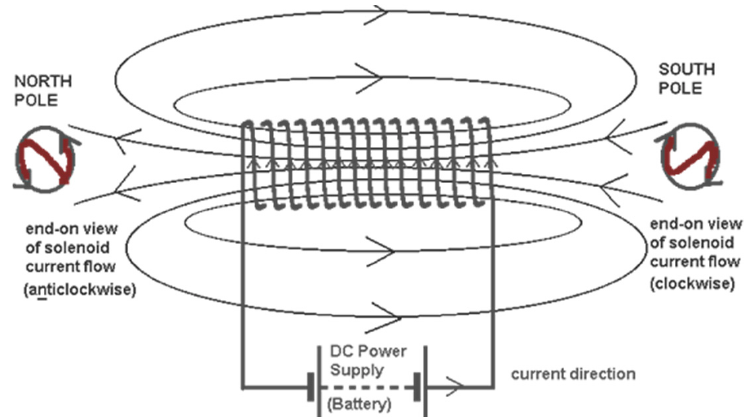
Figure 1. Solenoid Magnetic Field Lines with DC Current [15] .